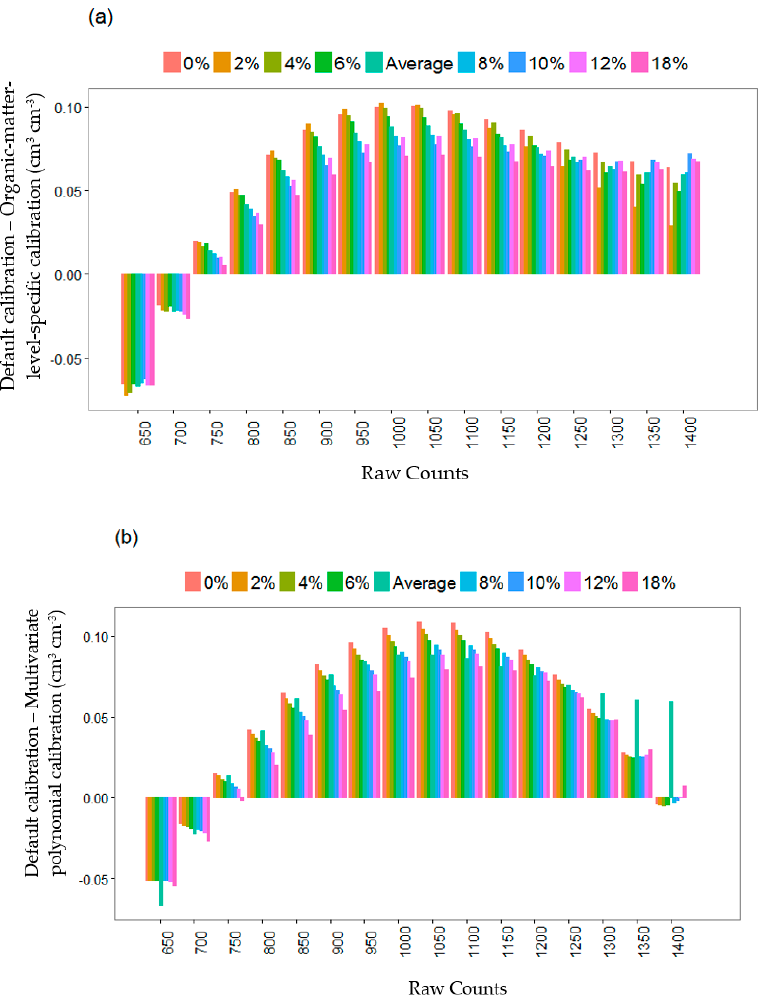
Figure 7. Uncertainties of the default calibration equation compared with organic-matter-level–specific calibration ( a ) and multivariate polynomial calibration equation ( b ).